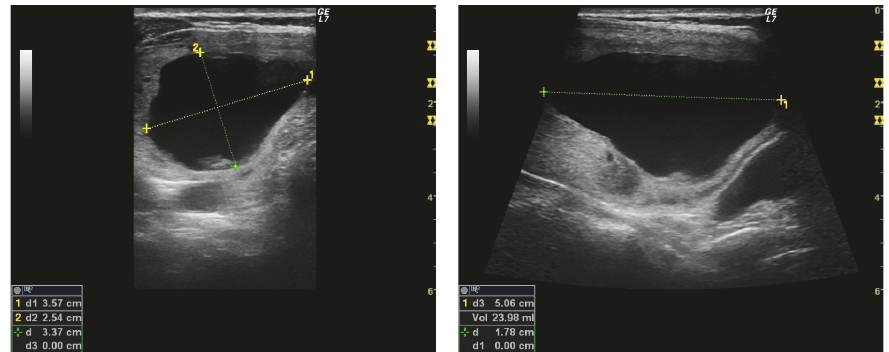
Figure 1: Right lobe thyroid cystic nodule at baseline.